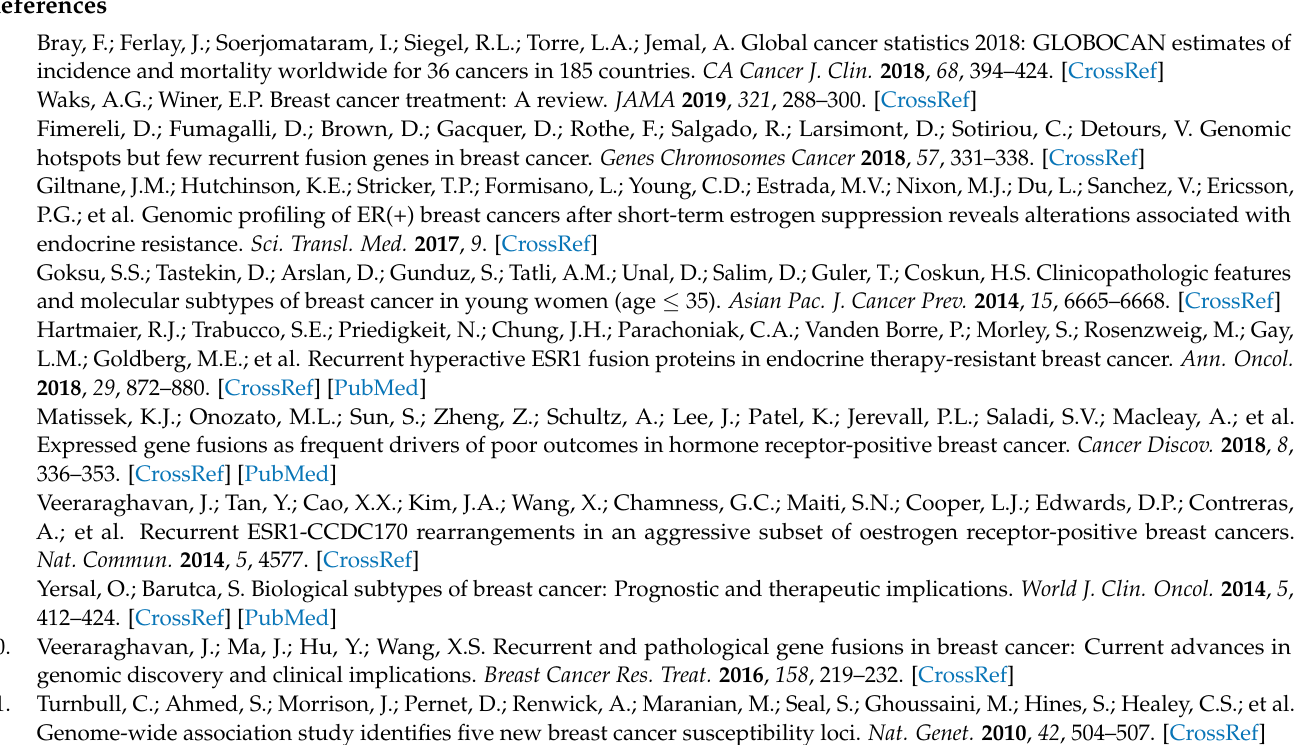
Table S2: Thirty-nine genes with hits of multiple pathways, Table S3: Putative target genes involved in three major pathways of CCDC170 high expression group without